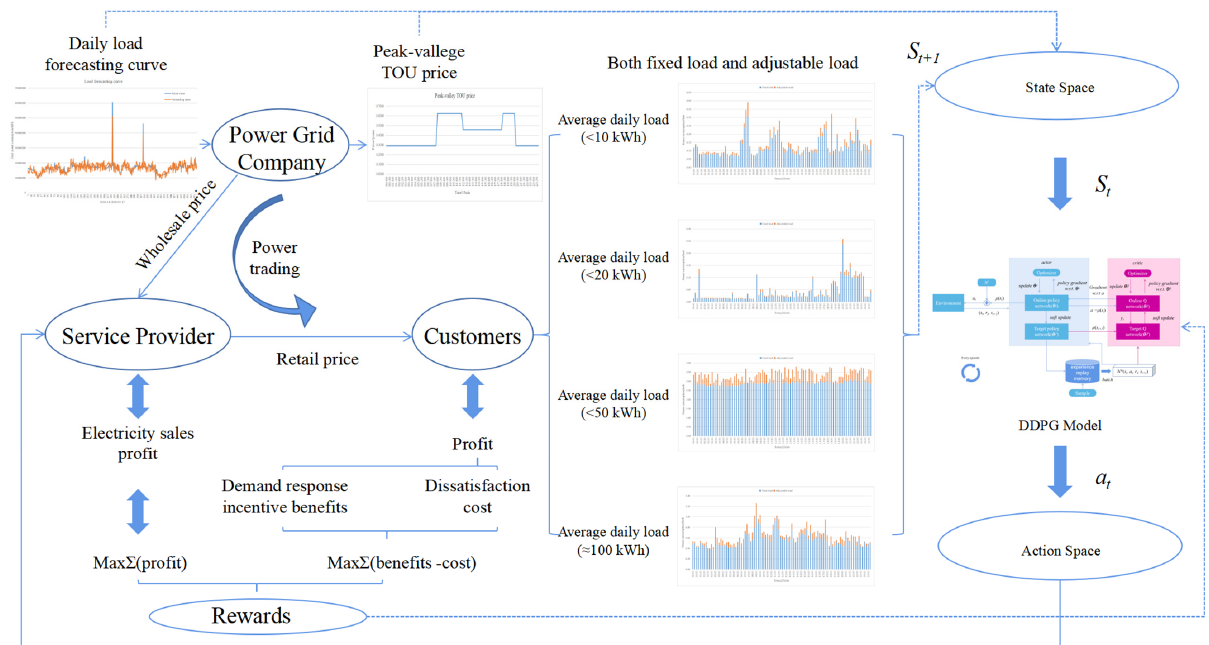
Figure 2. The optimal model of power consumption strategy based on DDPG.